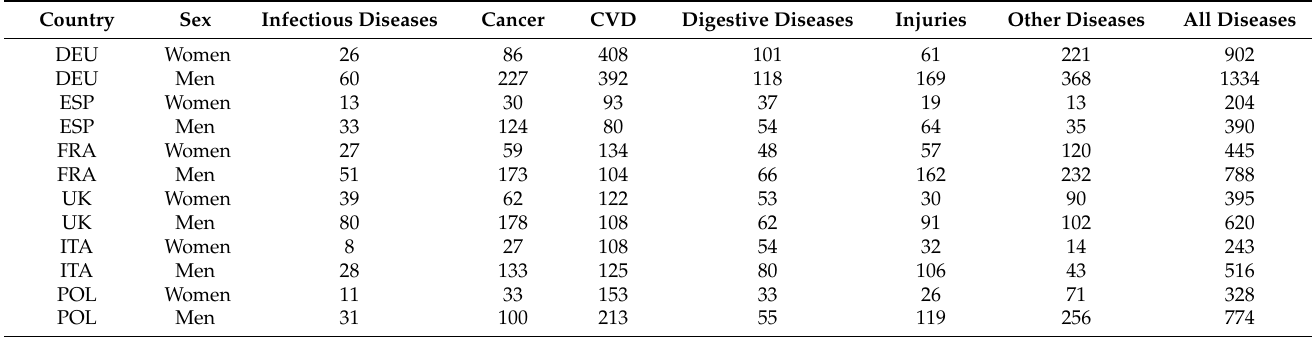
Table A4. Causes of death averted by a 5% reduction of alcoholic strength in 2019 by country and sex.